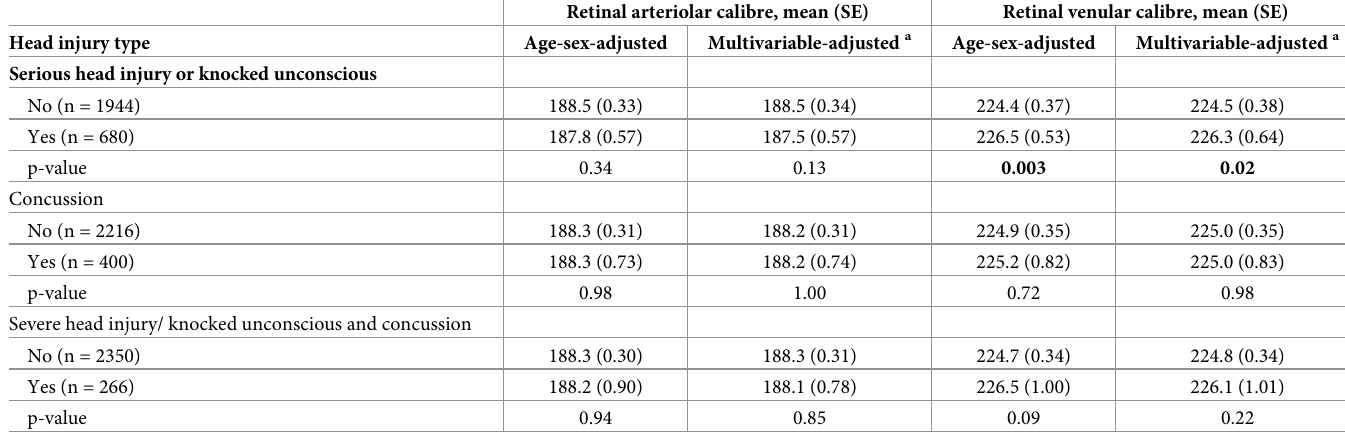
Table 2. Cross-sectional association between head injury, concussion and retinal vessel caliber in older adults (n = 2624). Retinal arteriolar calibre, mean